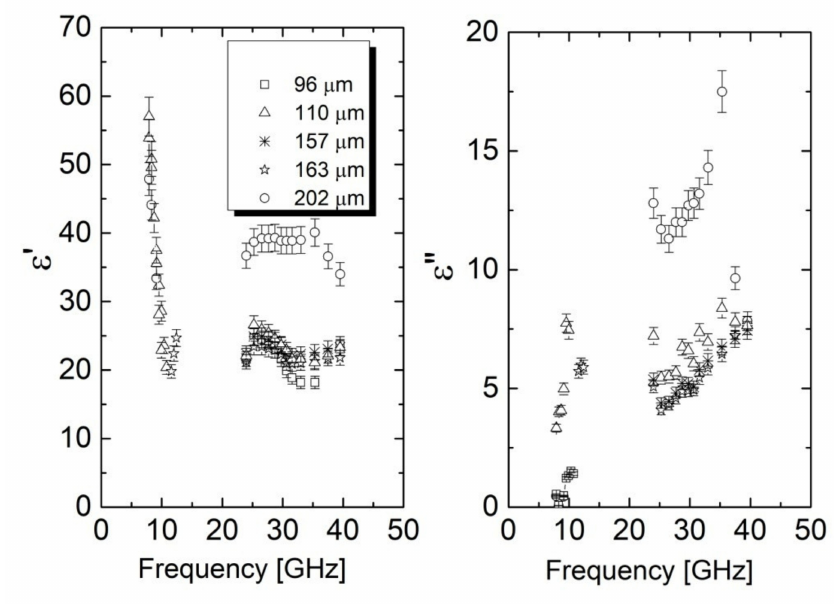
Figure 6. Frequency dependence of complex dielectric permittivity for coPA_A + 7 wt% MWCNTs fibers with different diameter.